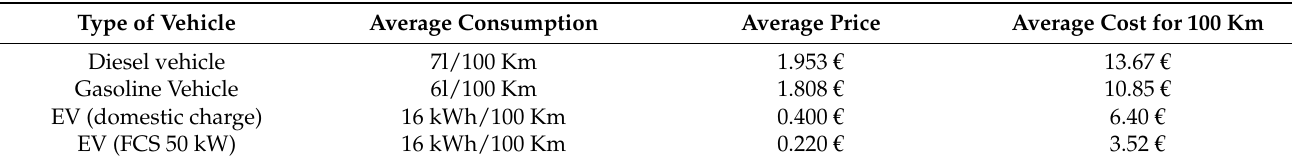
Table 1. Operational costs of traveling 100 Km for different types of